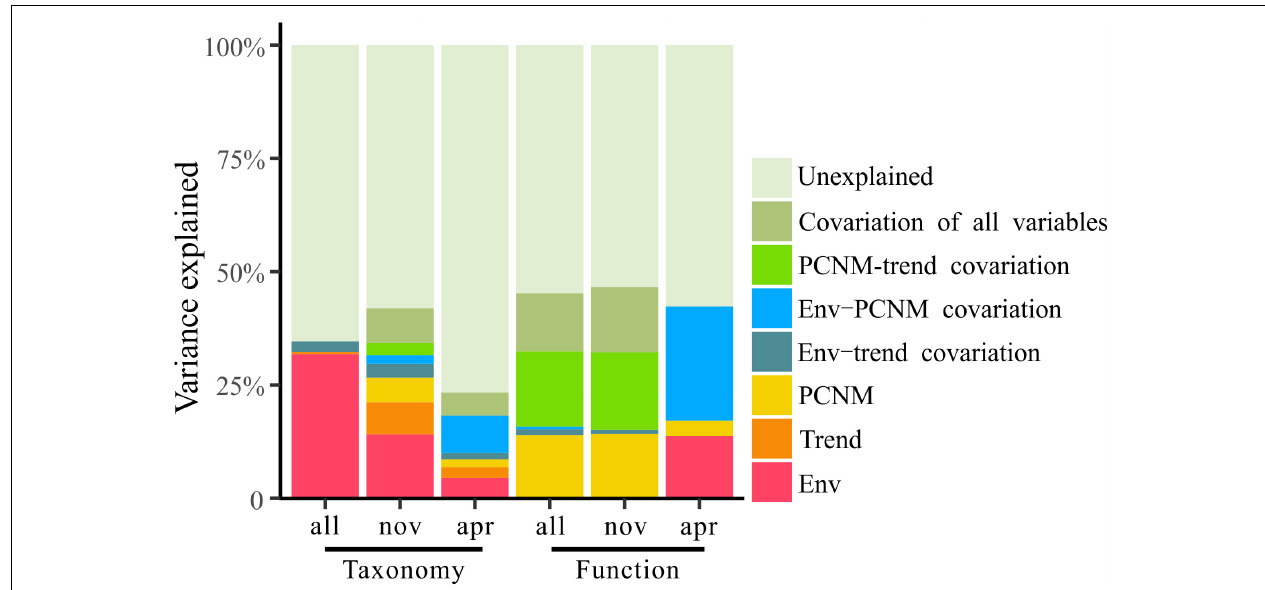
FIGURE 8 | Variation partitioning of the taxonomic and functional structure of total bacterioplankton communities (all) and the bacterioplankton communities collected in November (nov) and April (apr) by the seawater environmental variables (Env) and the spatial variables including linear trend (Trend) and PCNM variables